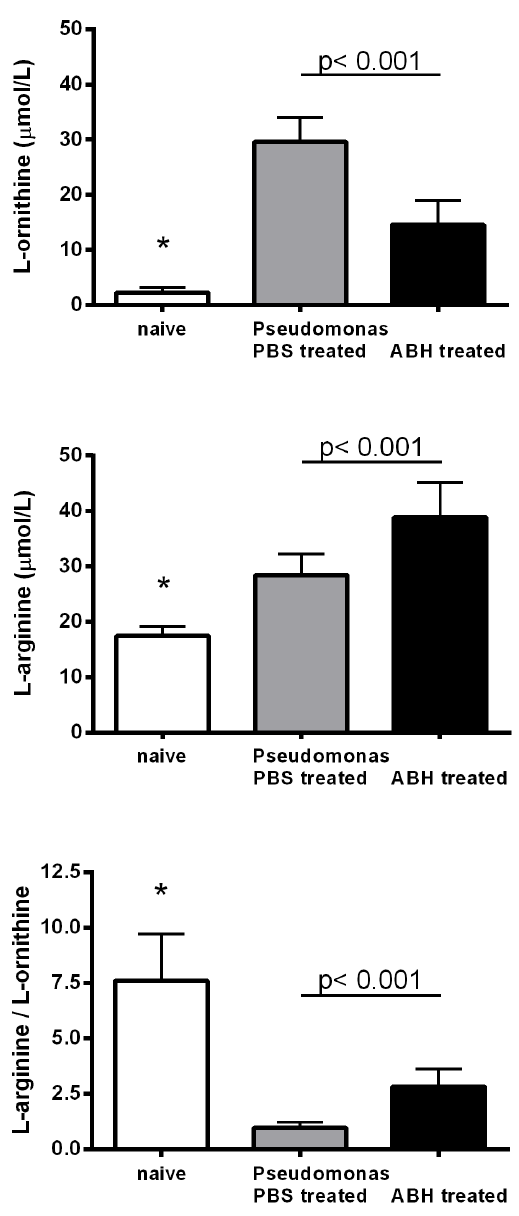
Figure 1. Concentrations of the amino acids L-ornithine and L- arginine in mouse lung homogenates of untreated (naı¨ve) control as well as Pseudomonas infected mice treated with PBS or the arginase inhibitor 2(S)-amino-6-boronohexanoic acid (ABH). L-ornithine, the product of arginase activity, as well as L- arginine was significantly lower in naı¨ve, compared to infected lungs (*: p , 0.0001, ANOVA, respectively). ABH treatment resulted in a significant decrease in L-ornithine but increase in L-arginine concen- tration (p , 0.001, t-test, respectively). The L-arginine/L-ornithine ratio, which can be used as an index of L-arginine availability for intracellular NOS, was reduced in infected lungs (*: p , 0.0001, ANOVA) but improved in the ABH treatment group (p , 0.001, t-test).